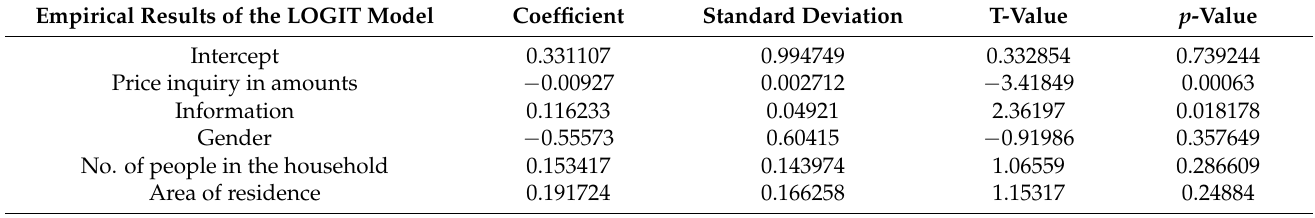
Table 6. The empirical results of the LOGIT model.